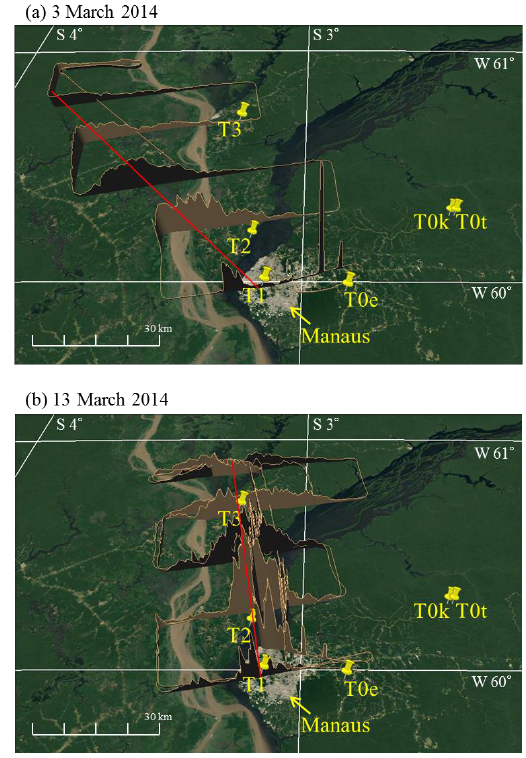
Figure 3. Visualization of the Manaus pollution plume by plot- ting particle number concentrations in the vertical axis. Observa- tions took place on flights from late morning to early afternoon on (a) 3 March 2014, 17:45–19:26UTC, and (b) 13 March 2014, 14:14–17:21UTC. Local time is UTC − 4h. The red lines guide the eye through the central axis of the plume. The direction and extent of the plume was observed by the G-1 aircraft within the at- mospheric boundary layer downwind of Manaus. Measured particle number concentrations are plotted on a vertical axis on top of an im- age of land cover in the horizontal plane. Particle concentrations in the center of the plume ranged from 10000 to 25000cm − 3 nearby Manaus. Yellow pins indicate the locations of some of the GoAma- zon2014/5 research sites, including T3 (Martin et al.,